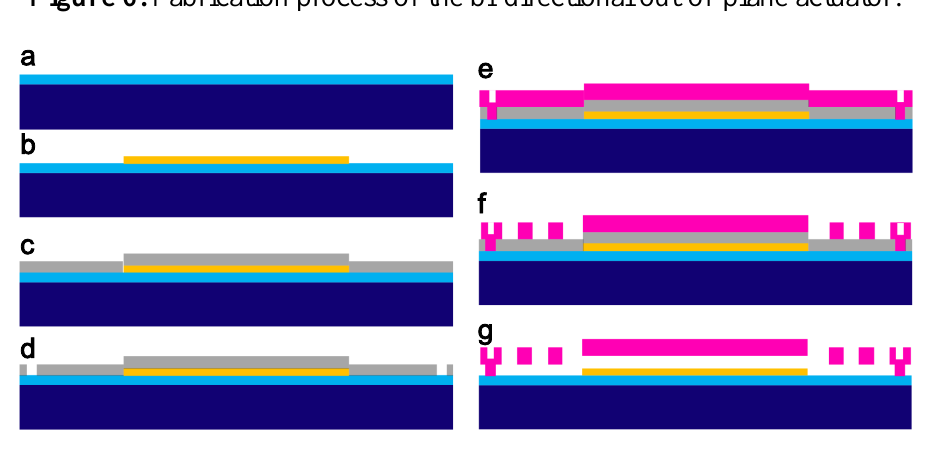
Figure 6. Fabrication process of the bi-directional out-of-plane actuator.